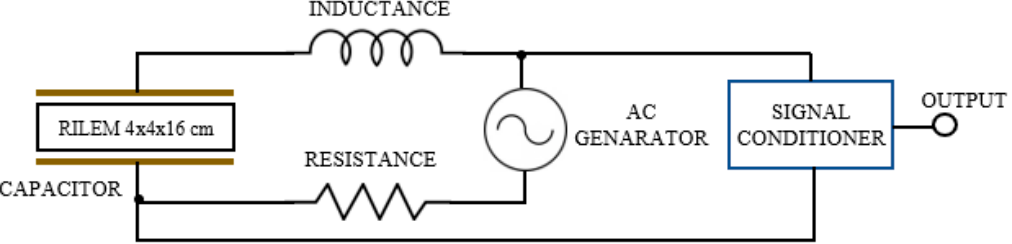
Figure 6. Diagram of the capacitive sensor developed for taking measurements. RILEM: (The International Union of Laboratories and Experts in Construction Materials, Systems, and Structures)